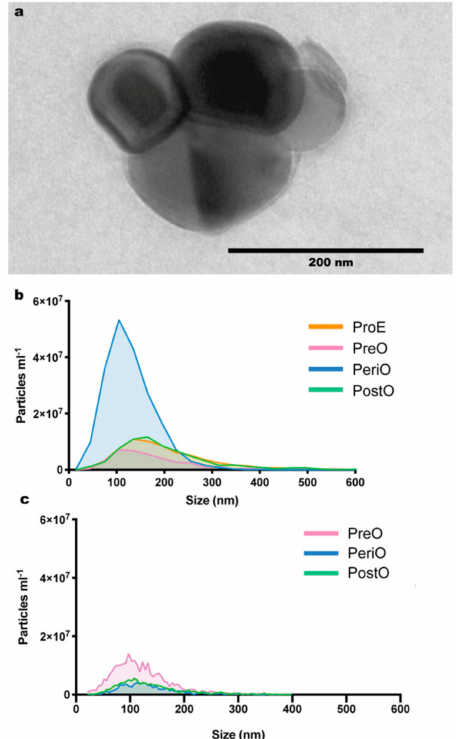
Figure 1. Cat and dog oviductal extracellular vesicle (oEV) analysis. In ( a ), transmission